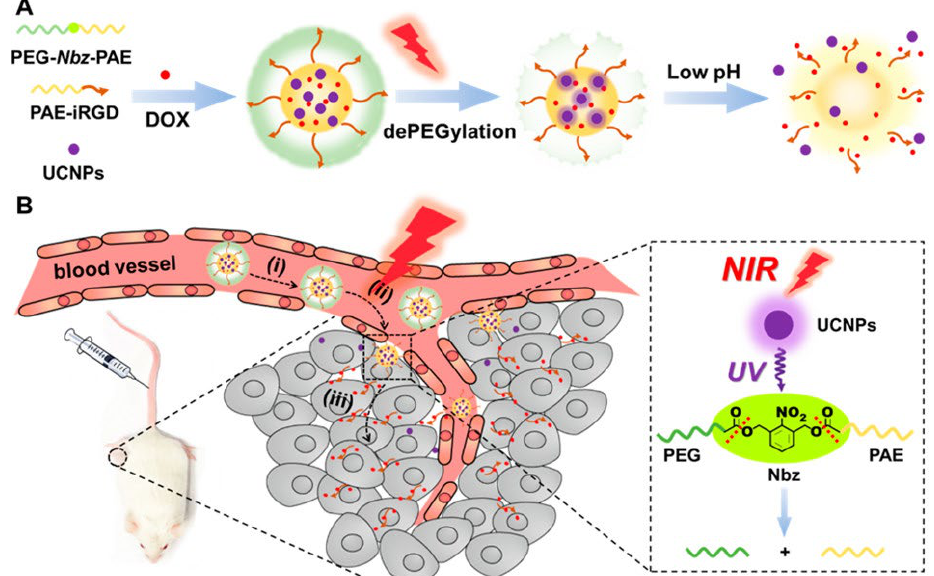
Figure 8. Schematic illustration of both UCNPs and DOX loaded complex micelles with the capability of converting the irradiated NIR to UV light for light-trigged cancer targeting and intracellular drug release. Reprinted with permission from Ref. [140]; American Chemical Society. ( A ) The formation of the micelles, NIR light-triggered DePEGylation and pH-triggered drug release; ( B ) i: Blood circulation of the micelles; ii: accumulation in the tumor through EPR effect; iii: Up-conversion of NIR to UV for DePEGylation.